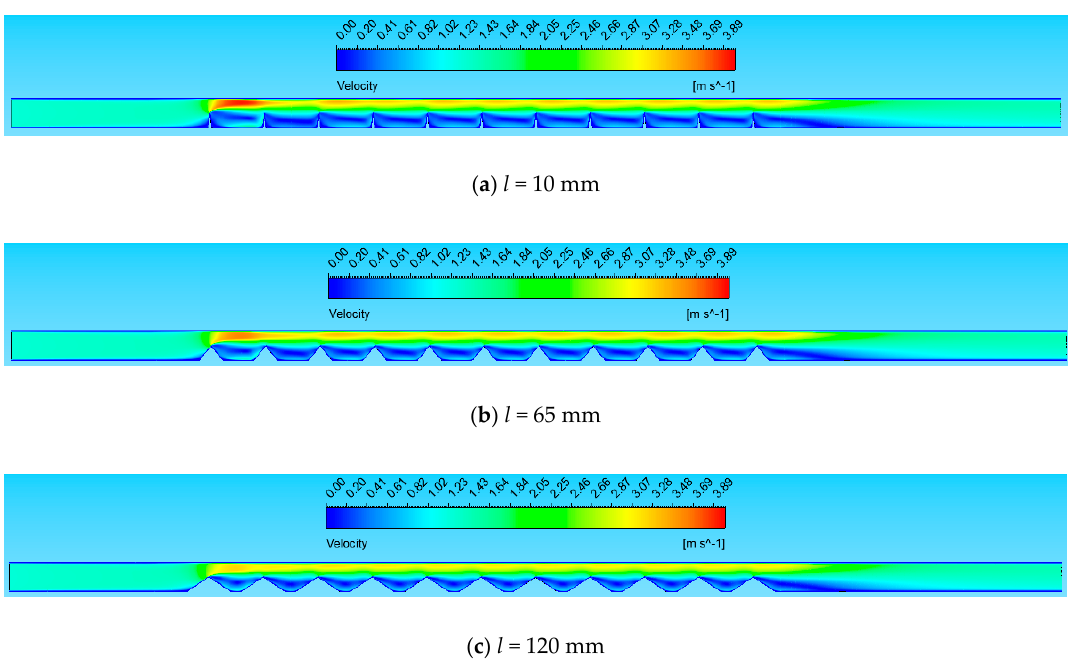
Figure 7. Variation of temperature in the test section at Reynolds number of 12,000, for a fixed value of height ( e = 40 mm) and length ( l = 65 mm), and for different value of pitch ( P ).